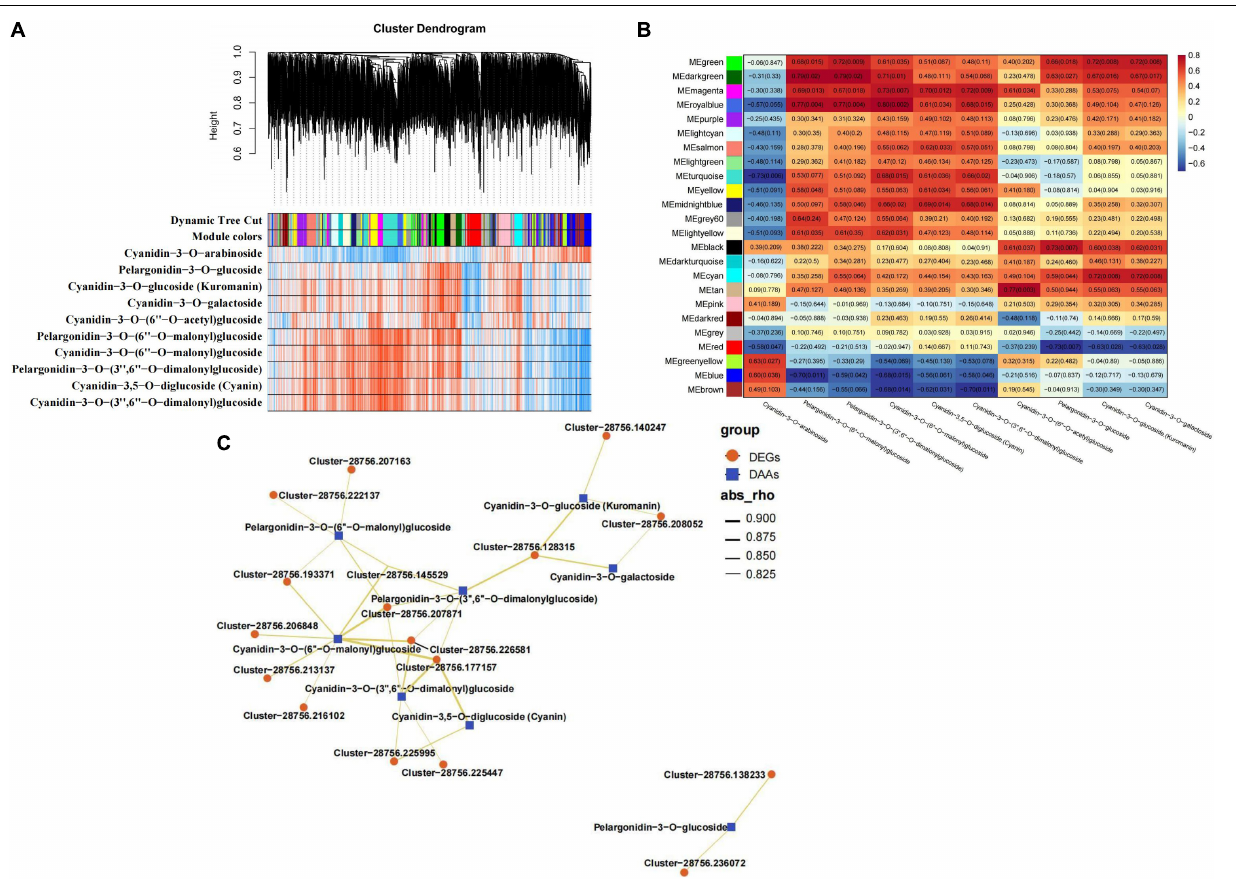
FIGURE 4 | WGCNA results of 2140 DEGs (with 10 DAAs |PCC| > 0.80). (A) Hierarchical clustering tree (cluster dendrogram) results showed 24 expression modules, labeled with different colors. (B) Module-anthocyanin relationship analysis. The value inside each box represents Pearson’s correlation coefficient between the module with anthocyanin, and the number in each parentheses represents p -value. The color scale on the right represents the degree of correlation between modules and anthocyanins and the red represent high correlation. (C) The interaction network diagram between DEGs and 10 DAAs. Red triangles represent DEGs and blue triangles represent